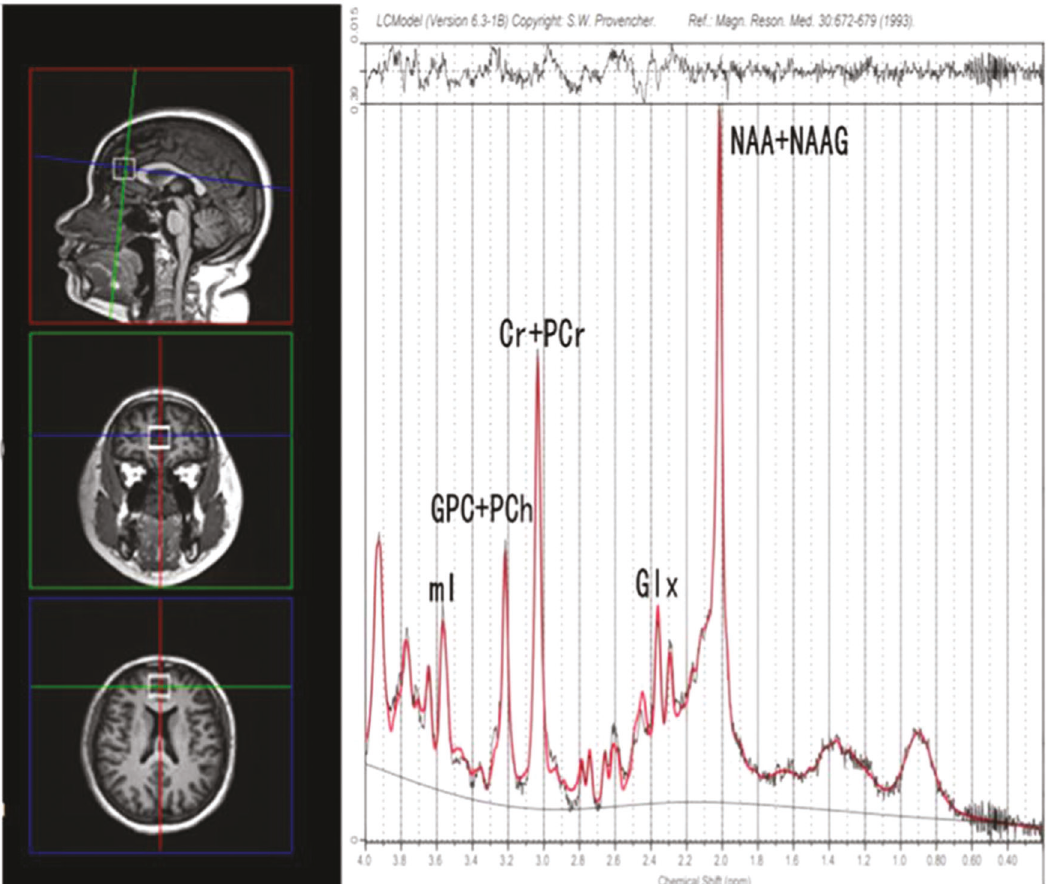
Fig. 1 The location and sample spectrum of the voxel of interest in the medial prefrontal cortex (mPFC). The voxel dimension is 20 × 20 × 20 mm 3